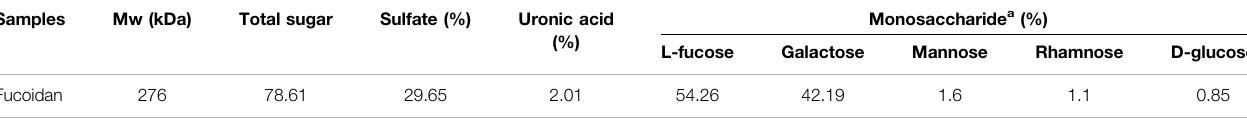
TABLE 1 | The Mw and chemical composition of